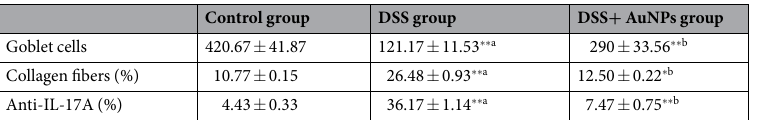
Table 3. Number of goblet cells, area percentage of collagen fibers and area percentage of positive anti- IL-17A immune reactions in different groups. Values are expressed as mean ± standard error of means (SEM) of n = 8 animals. a P compared with control group. b P compared with DSS group. ∗ Significant difference ( P < 0.05). ∗∗ Highly significant difference ( P <